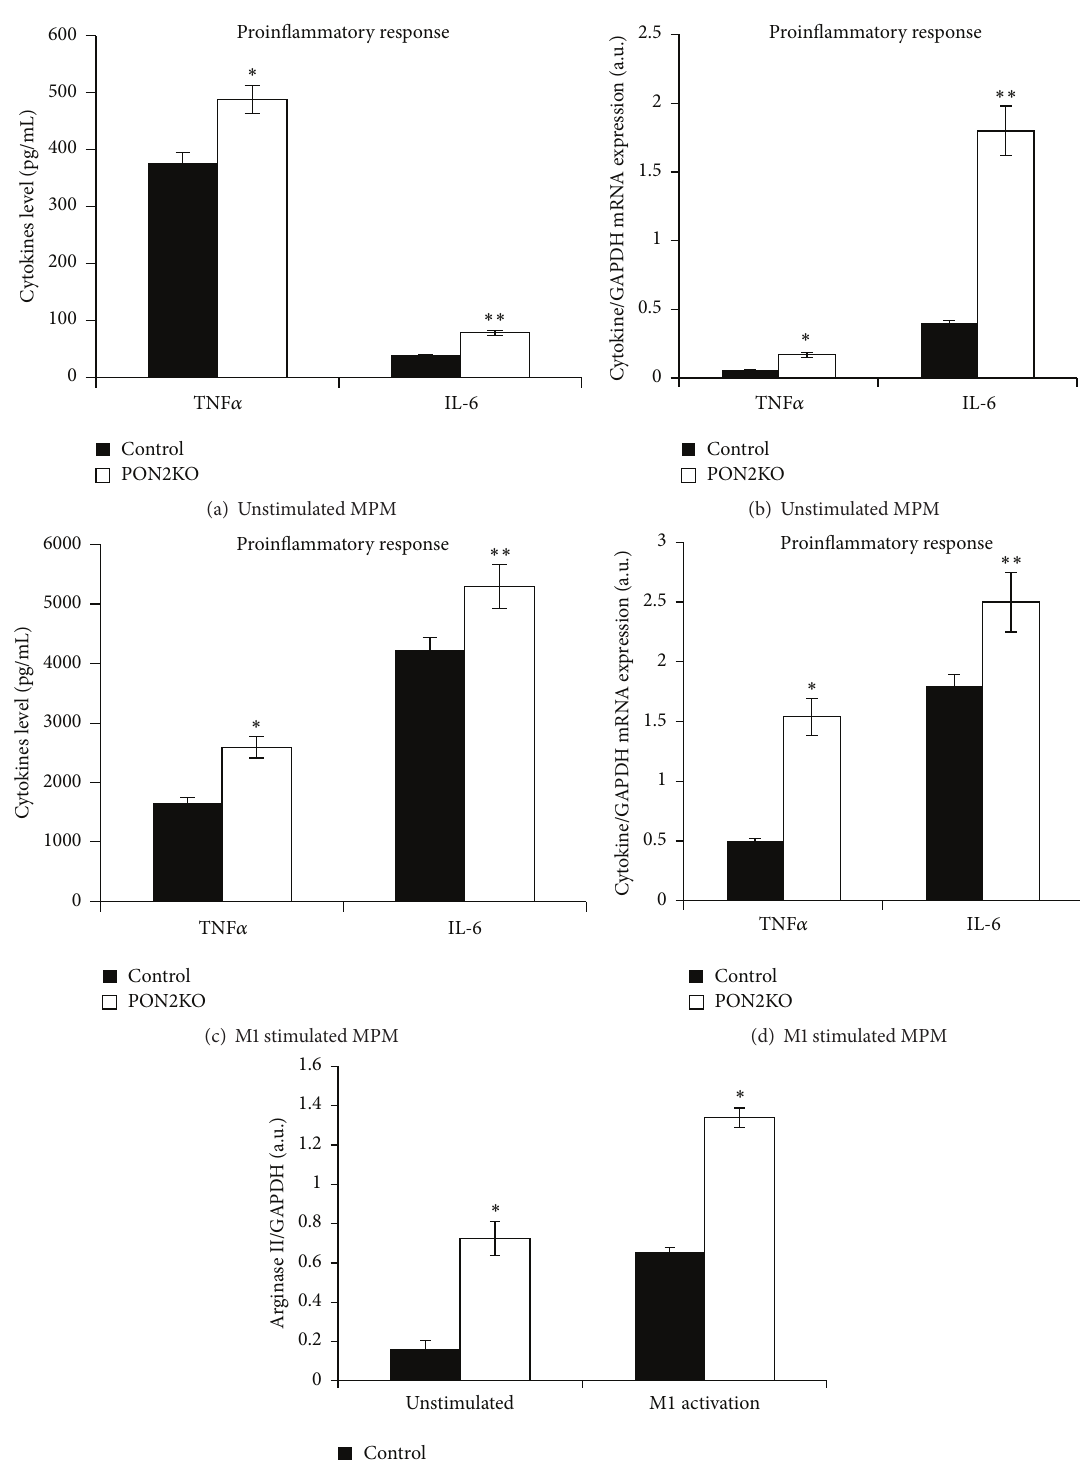
Figure 1: MPM from PON2KO display increased proinflammatory activation. MPM were harvested from 3-month-old control (C57BL/6) male mice and from age matched PON2KO mice. The cells were stimulated toward M1 activation with LPS (100ng/mL) and IFN 𝛾 (20ng/mL) for 12 hours. Secretion of TNF 𝛼 and IL-6 to the medium was measured under basal (a) or M1 stimulation (c) conditions. TNF 𝛼 and IL-6 mRNA expression, analyzed by quantitative PCR and normalized to GAPDH, were measured in the cells under basal (b) or M1 stimulation (d) conditions. Arginase II mRNA expression was also measured under basal or M1 stimulation conditions (e). Results are expressed as mean ± SD ( 𝑛 = 3 ), ∗ 𝑃 < 0.03 , PON2KO versus control